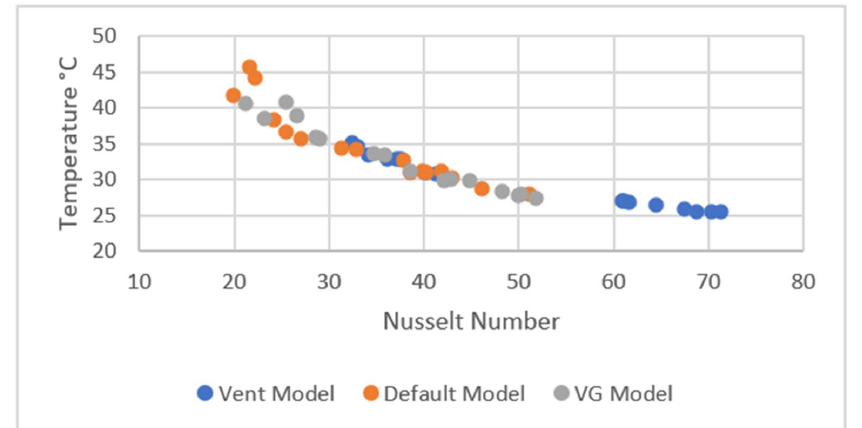
values have been plotted with temperature in Figure 23.